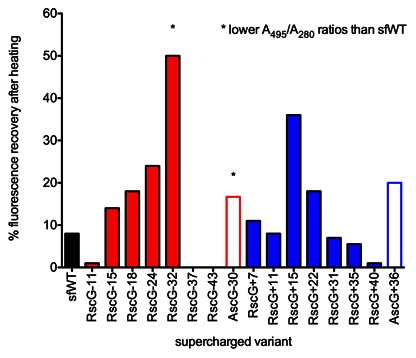
Percent recovery of fluorescence after heating GFP variants to 95°C for 3 minutes.All variants were tested at 2 µM concentration. Some variants demonstrated poor A495/A280 ratios and should not be directly compared to sfWT (RscG−32 and AscG−30). Improvements to refolding are 3-fold for RscG−24 and 4.5-fold for RscG+15.